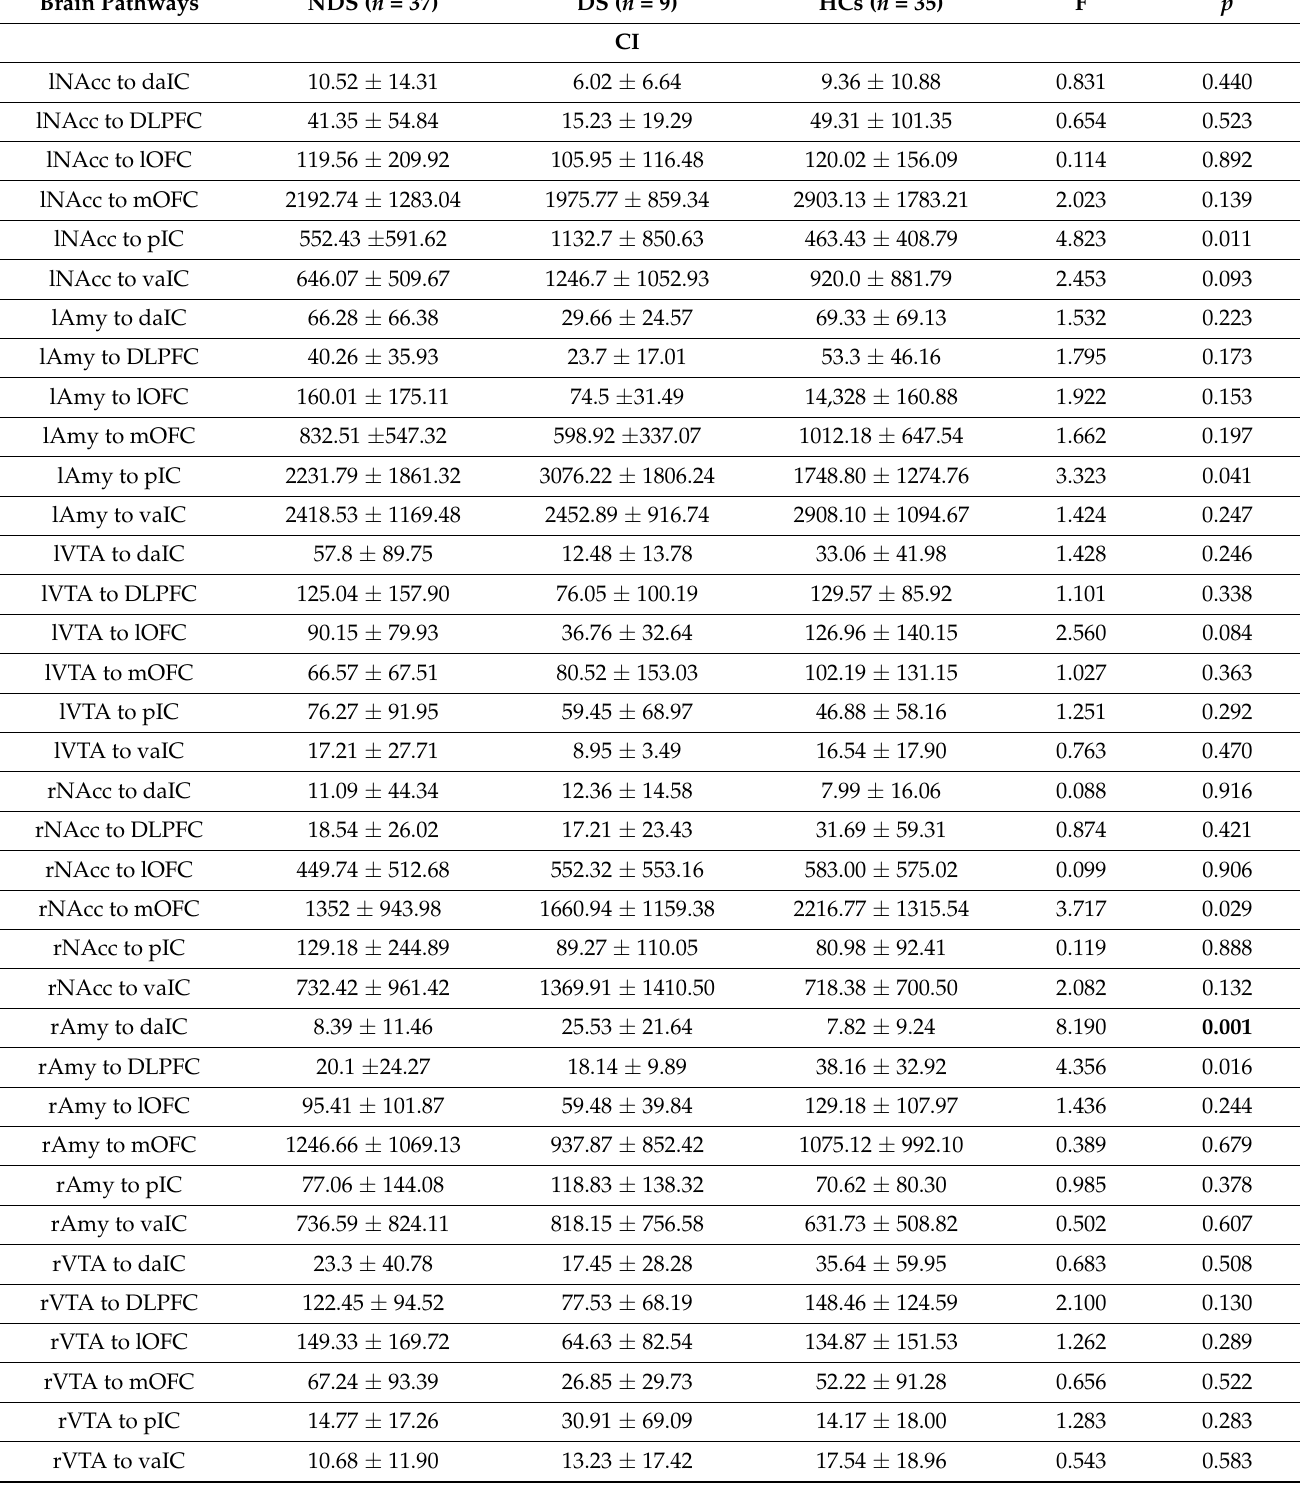
Table 2. Group differences between DS, NDS and HCs in